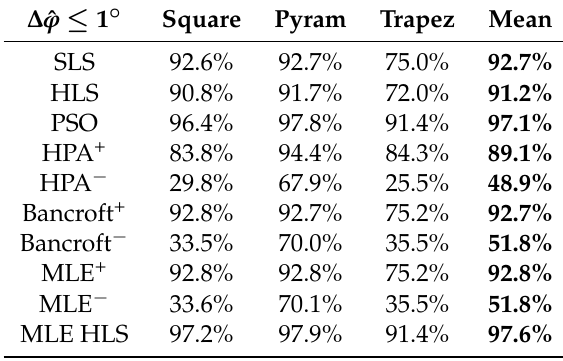
Table 8. Percentage of positions analysed located with an azimuth angle error ∆ ˆ ϕ lower than 1 ◦ under time sampled digitizing error for each algorithm and antenna array